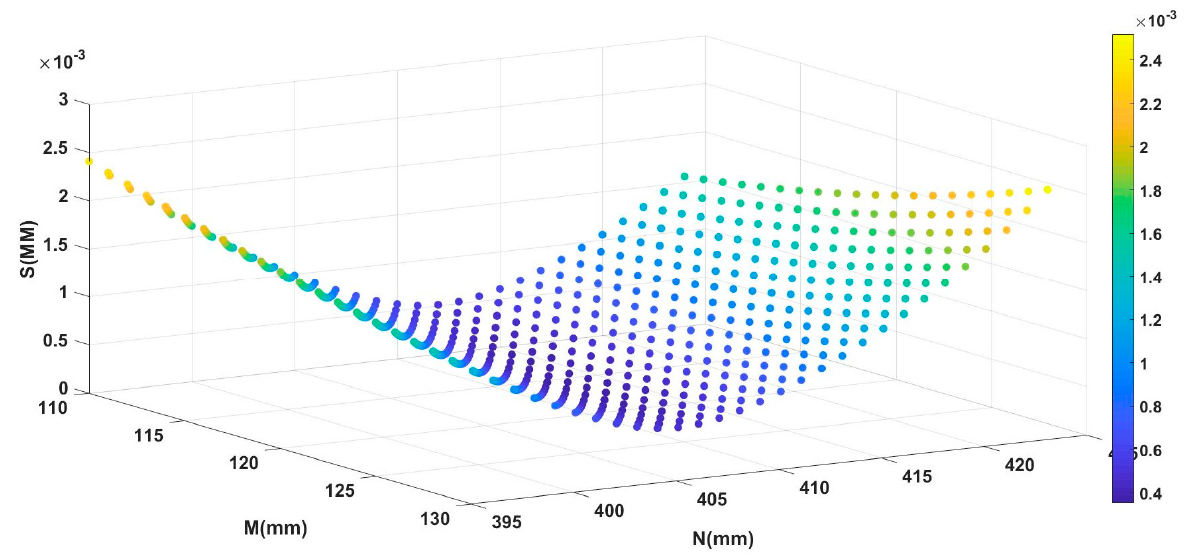
Figure 6. The relationship between the root-mean-squared error S value and the parameters M and N. Table 1. Calibration results of parameters M and N.